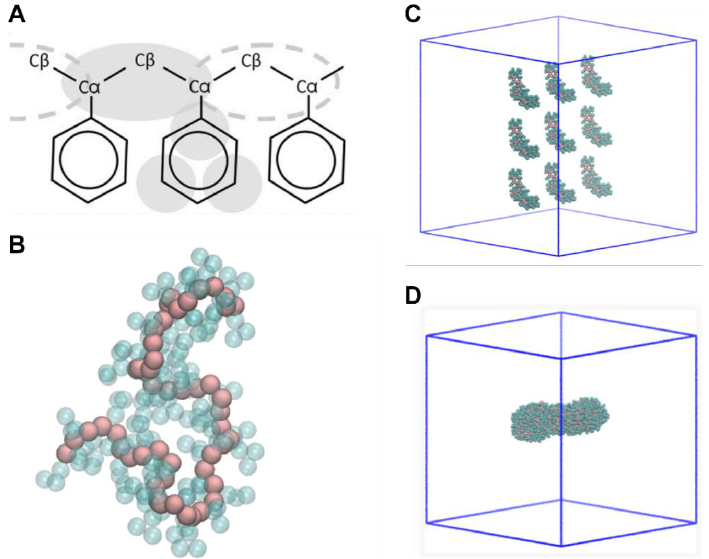
Figure 7. Schematics of the NP molecular models’ construction. ( A ) CG mapping of polystyrene [33]. Figure 7 . Schematics of the NP molecular models ’ construction. ( A ) CG mapping of polystyrene 322